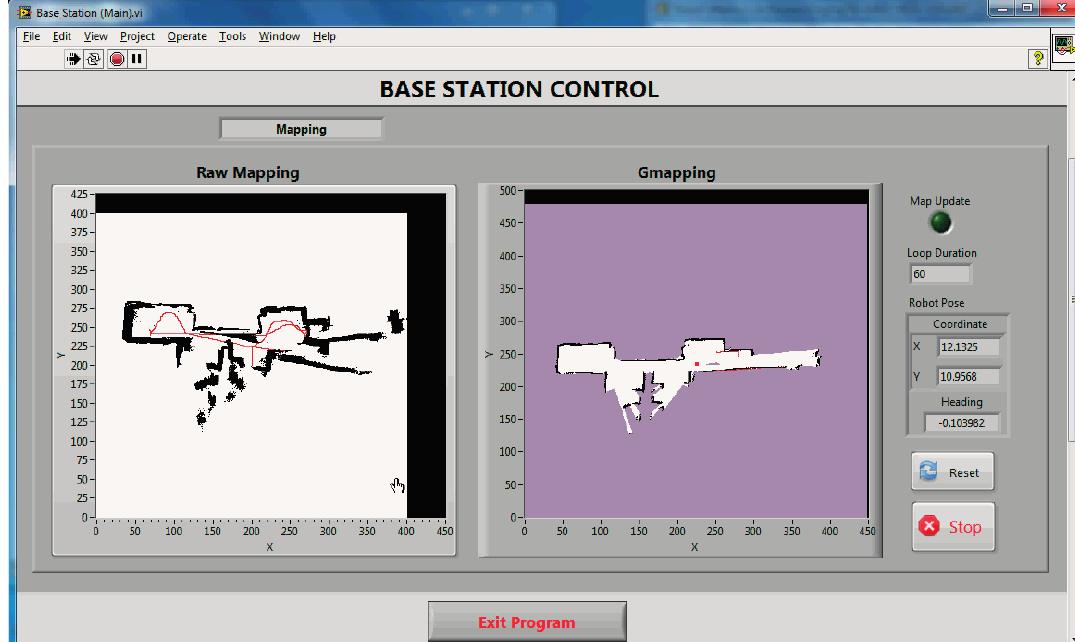
Figure 6. Front panel showing the map of the corridor in Test 1. The red line in the raw map shows the trajectory of the robot based on the odometry data, while the red dot and line in Gmapping map indicate robot pose and obstacle location from the Kinect.